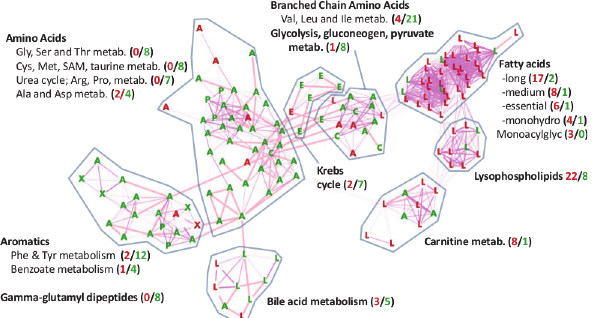
Figure 5. Higher levels of lipid and lower levels of amino acid metabolites in plasma of AggE vs. Ctrl mice at 4 wks after AggE-withdrawal. Shown are individual metabolites that were lower (green) or higher (red) in AggE vs. Ctrl mice at 4 wks post-AggE. Metabolites are shown for subpathways that had metabolites that were coordinately regulated (shown in Fig. 3) or that had significantly different numbers of higher or lower metabolites in AggE mice (shown in Fig. 4). The node labels indicate the superpathway designation of the metabolites: A , Amino acid; C , Carbohydrate; L , lipid; E , energy; P , Peptide; and X , xenobiotic. The metabolites are distributed using a force-directed, edge-unweighted algorithm in Cytoscape [89], with biochemical relationships shown as pink edges (KEGG) and structural similarities shown as violet edges (Tanimoto similarity > 0.7). Metabolites for which a KEGG or PubChem Compound (CID) Identifier was available are shown. Numbers in parentheses indicate the number of elevated (red) and suppressed